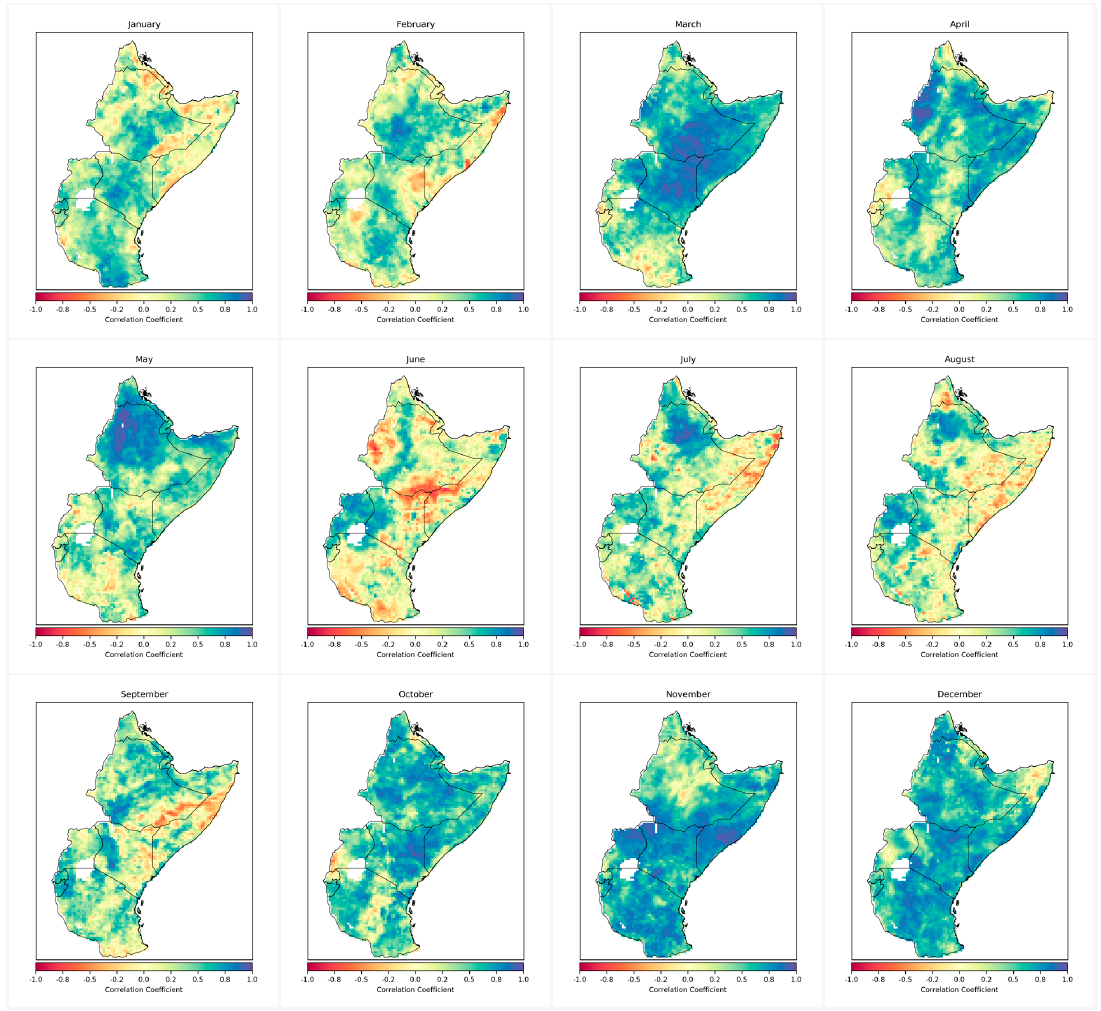
Figure A2. Pearson correlation coefficient for monthly CHIRPS and ESI (2003–2016).